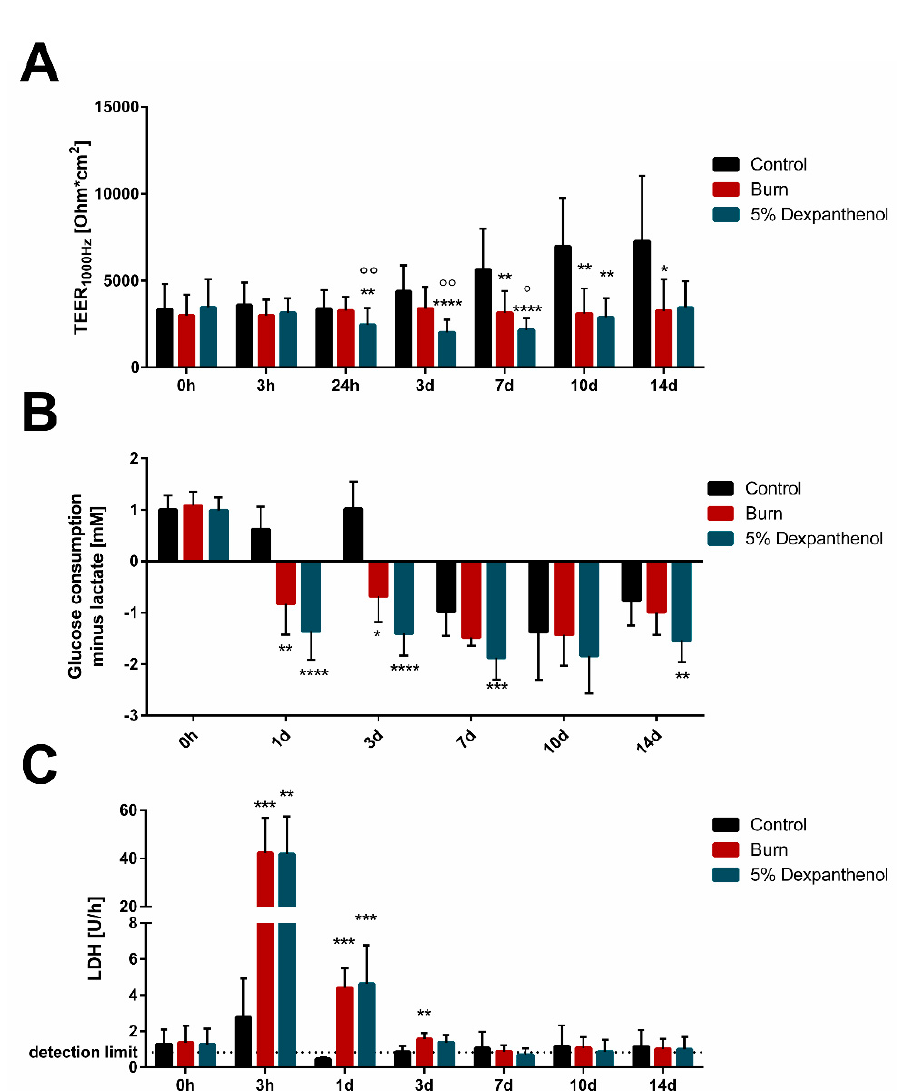
Figure 6. Burning influences skin barrier, causes release of intracellular LDH and stress-related metabolic differences in OS-REp. ( A ) Transepithelial electrical resistance (TEER 1000 Hz ) was measured with a custom-made system before (0 h) and at certain time points after burning. It revealed stagnation in TEER 1000 Hz values of burned models, while the control’s TEER 1000 Hz increased over cultivation time. (3 biological replicates in independent test runs with 4–12 technical replicates each; mean values ± SD; Kruskal-Wallis test with Dunn’s multiple comparisons test, * p < 0.05, ** p < 0.01, **** p < 0.0001 compared to the control. ◦ p < 0.05, ◦◦ p < 0.01 compared to burned models). ( B ) Glucose consumption subtracted by lactate production in mM. The glucose consumption is calculated in comparison to the glucose level measured in the fresh medium. Burning results in a significant lower ratio for the first three days after burning in comparison to the control, no matter the treatment. Glucose consumption and lactate production values can be found in the supplements (Supplementary Figure S5) (3 biological replicates in independent test runs with 3 technical replicates each; mean values ± SD; Kruskal-Wallis test with Dunn’s multiple comparisons test, * p < 0.05, ** p < 0.01, *** p < 0.001, **** p < 0.0001 compared to the control). ( C ) Burning leads to cellular disruption and a peak of lactate dehydrogenase (LDH) levels in the supernatant directly after injury but decreases after 24 h (3 biological replicates in independent test runs with 3 technical replicates each; mean values ± SD; Kruskal-Wallis test with Dunn’s multiple comparisons test, ** p < 0.01, *** p < 0.001, compared to the